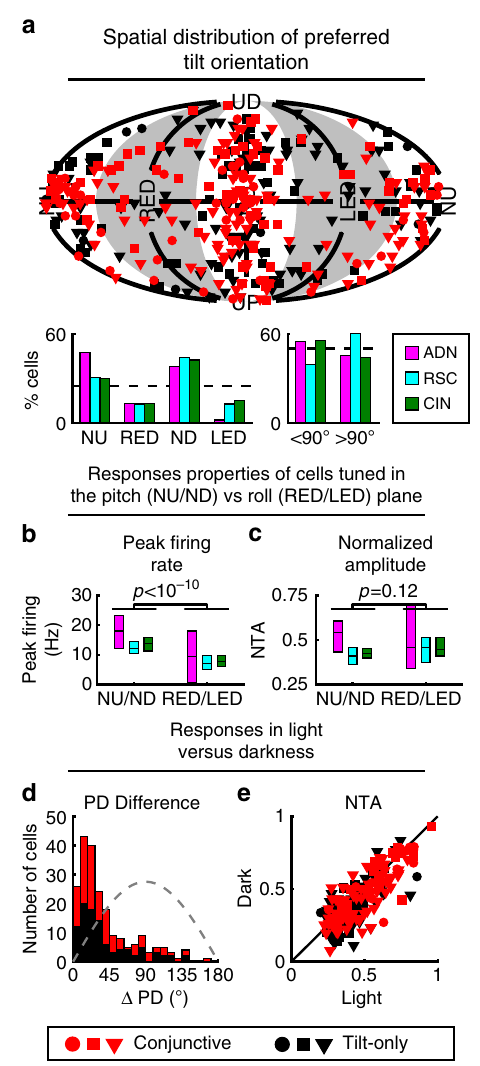
Fig. 5 Summary of 3D tilt tuning (based on full tuning curves measured in the rotator). a Top: Distribution of tilt PDs. Red: Conjunctive (azimuth and tilt) cells; Black: tilt-only cells. Circles, squares, triangles: ADN, RSC, CIN, respectively. Bottom: Number of cells with PD in the roll (RED/LED) or pitch (ND/NU) plane; and in upper (<90° tilt) or lower (>90° tilt) hemisphere, color-coded separately for each area (AND, CIN, RSC). b , c Comparison of peak fi ring rate ( b ) and NTA ( c ) of the tilt tuning curves of neurons with PD in the roll and pitch plane, color-coded by regions. Boxes represent the median and 95% con fi dence interval of the median. p -values are based on a Wilcoxon-rank sum test. d Distributions of absolute difference in tilt PD for light vs. darkness for conjunctive (red) and tilt-only (black) cells. Gray dashed line: expected distribution if PDs are independently distributed on a sphere. e Comparison of tilt peak-to-trough normalized tuning amplitude computed from Gaussian fi ts (Methods) in darkness vs. light. Red: Conjunctive (azimuth and tilt) cells; Black: tilt-only cells. Source data are provided as a Source Data fi each value w (e.g. with w = 0 and w = 1 in Fig. 6b) and tested